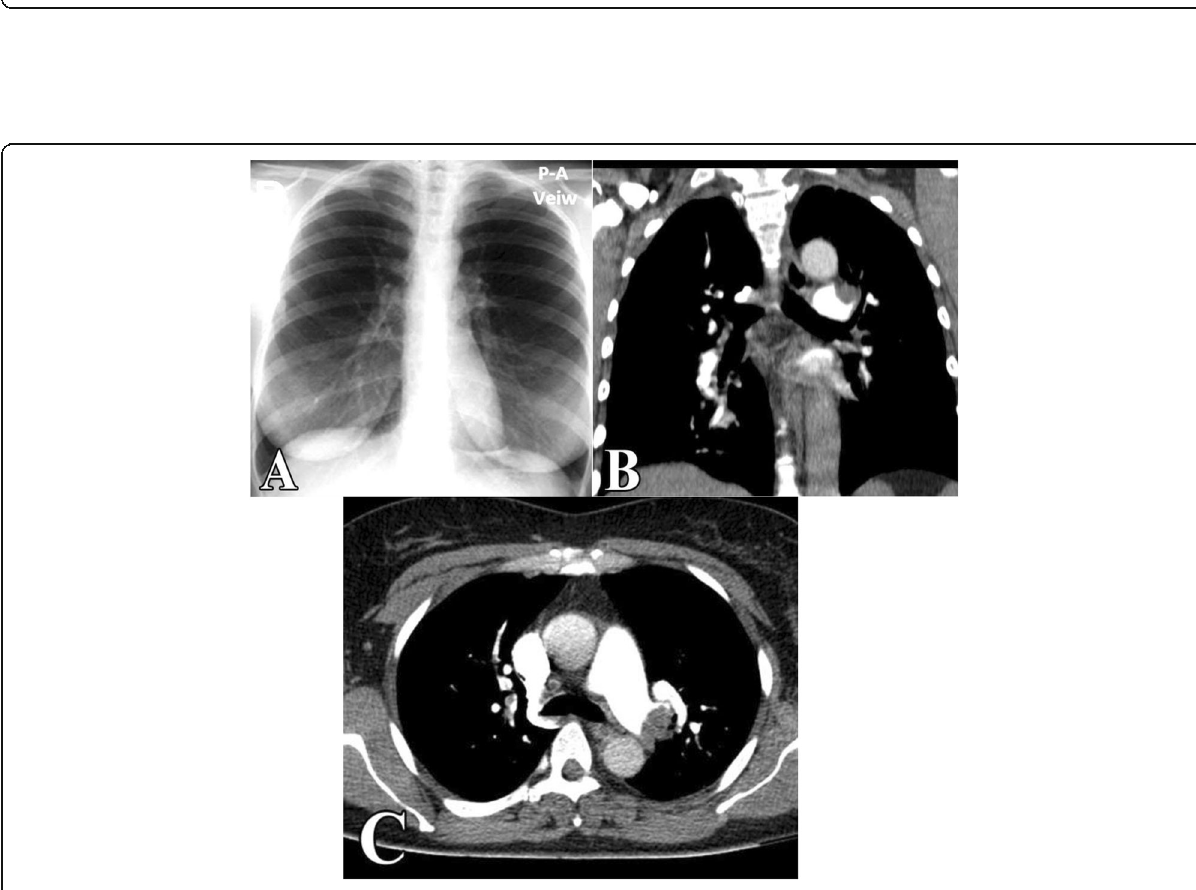
Fig. 6 A 46-year-old female patient underwent a surgical Roux-en-Y gastric bypass since 3 weeks presented with cough and dyspnea. a Plain X-ray chest (PA view): clear lung fields. b , c Post-contrast CT chest: multiple filling defects in the pulmonary artery. Diagnosis: acute pulmonary